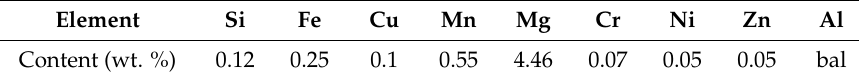
Table 1. Chemical composition (wt. %) of 5083 aluminum alloy.